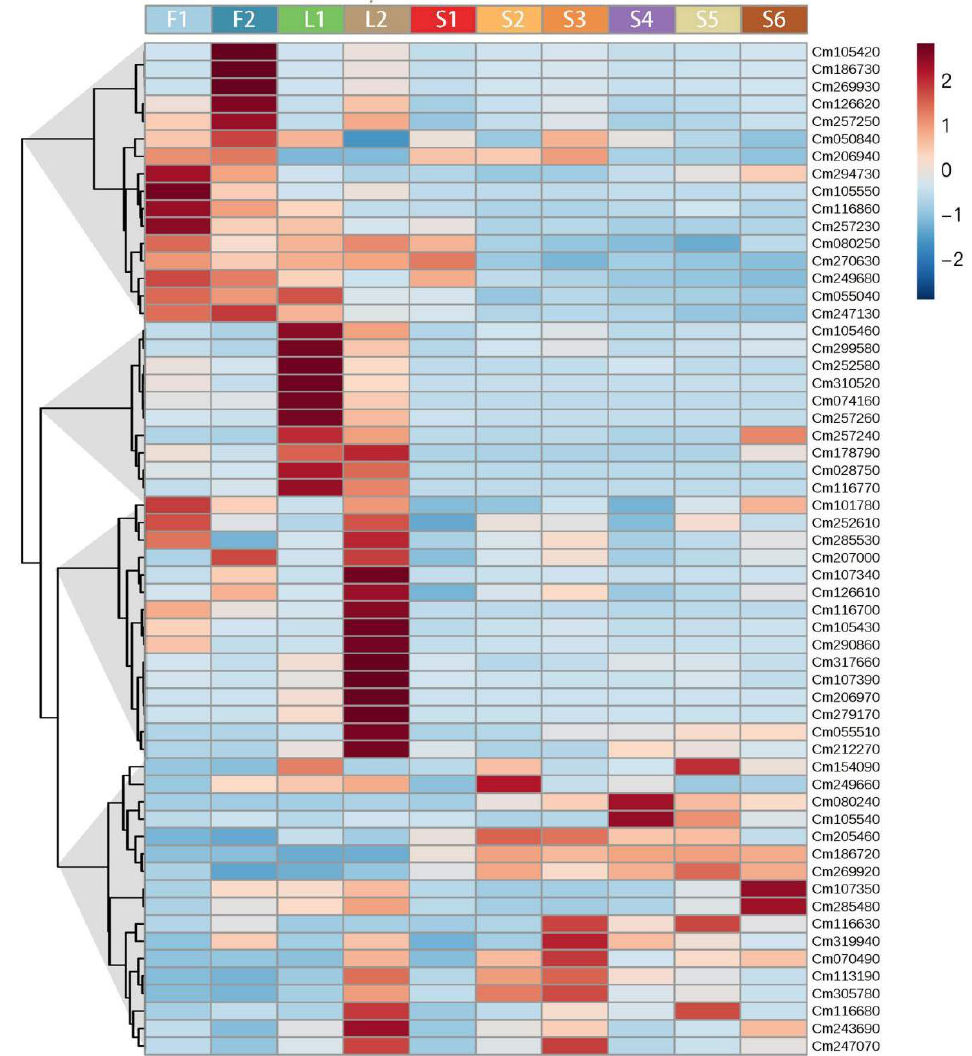
Figure 4. Hierarchical clustering and heat map visualization of changes in TPS gene expression level in developing finger citron organs. F1, flower bud; F2, full flower, L1, young leaf; L2, mature leaf; S1–6, fruit developing stages 1–6. The left side of the heat map represents hierarchical clustering based on Pearson correlation. The color scale ( − 2 to 2) is shown on the right; red represents high content, blue represents low content. Hierarchical clustering and heat map were constructed using MetaboAnalyst 4.0.